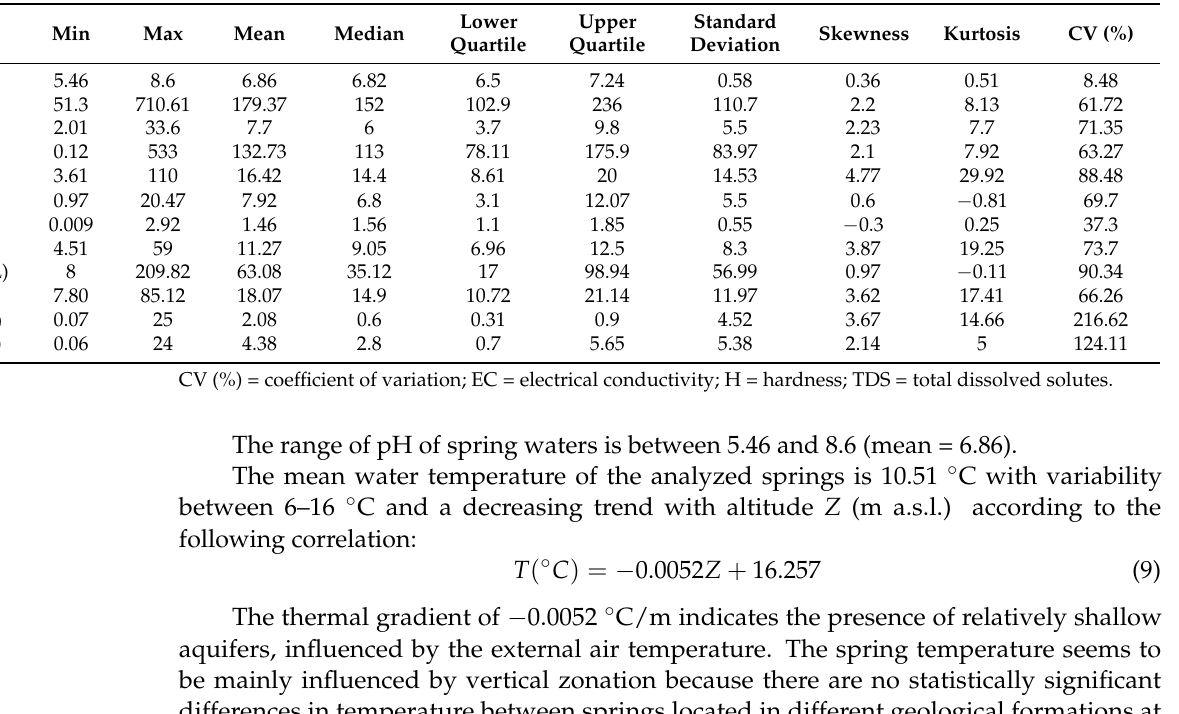
Table 1. Basic statistics for analyzed water